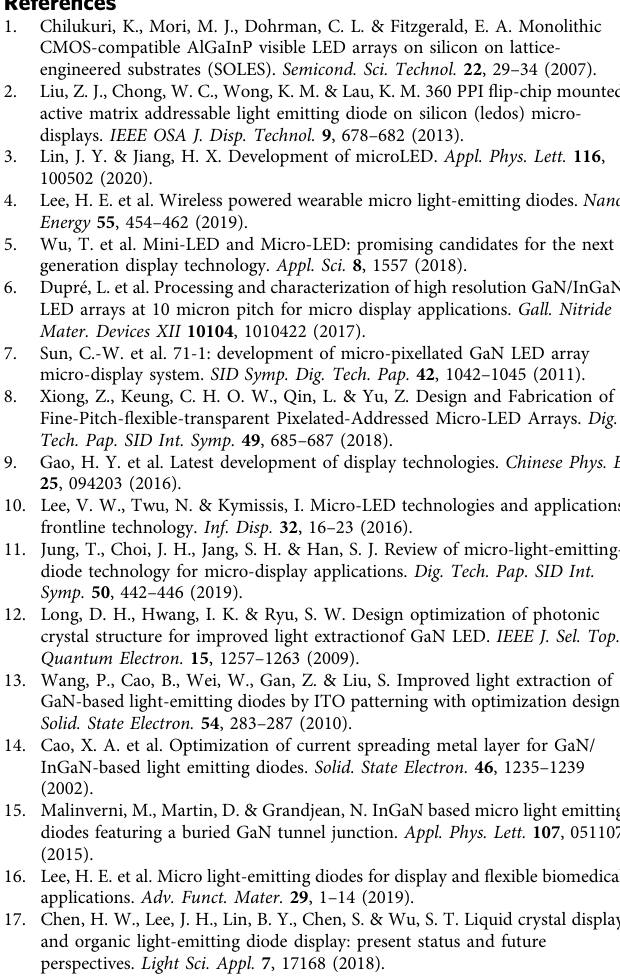
Distributed Bragg Re fl ector (DBR) implementation . The target total thickness of the DBR structure was 605 nm and alternating fi lms of SiO 2 and TiO 2 were used. ULS3648, Avantes), a probe station, and a source meter (Keithley 2602B). The measurement was set to a wavelength of 300 – 800 nm and the current values ranged from 0.1 μ A to 10 mA. From the spectral data, the color coordination for the CIE chromaticity chart was deduced. First, the tristimulus values X,Y,Z were deter- mined by the integral of the product of spectrum power and the color matching function for the corresponding red, green, blue spectrum. Then the CIE